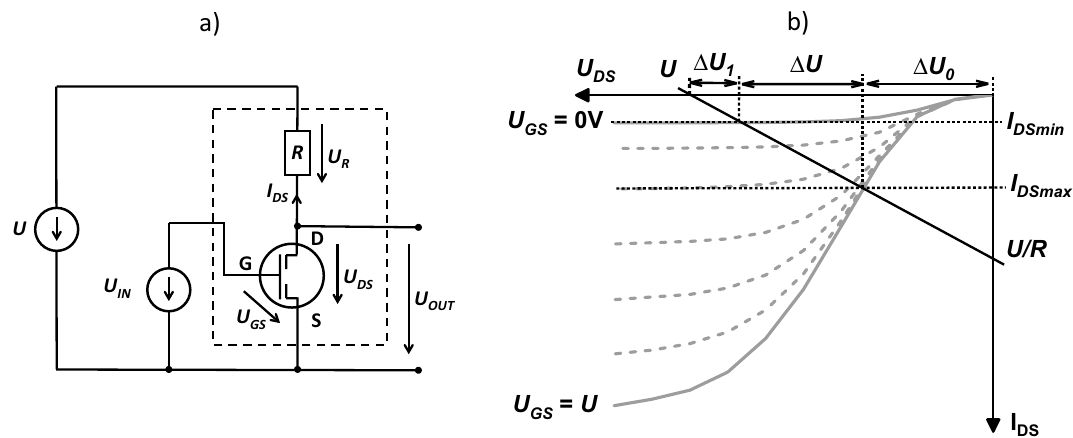
Figure 1. Schematic of the electrical circuit, including the tested voltage inverter (surrounded by dashed lines), power supply ( U ) and input voltage source ( U IN ) ( a ). Load line of the inverter with characteristic points of crossing with the axis (straight line), drawn on the output characteristic curve of the transistors (dashed and solid lines) ( b ). Dotted lines mark the maximum and minimum drain current ( I DSmin , I DSmax ) in the inverter and characteristic threshold voltages (Δ U 1 , Δ U and Δ U 0 ).